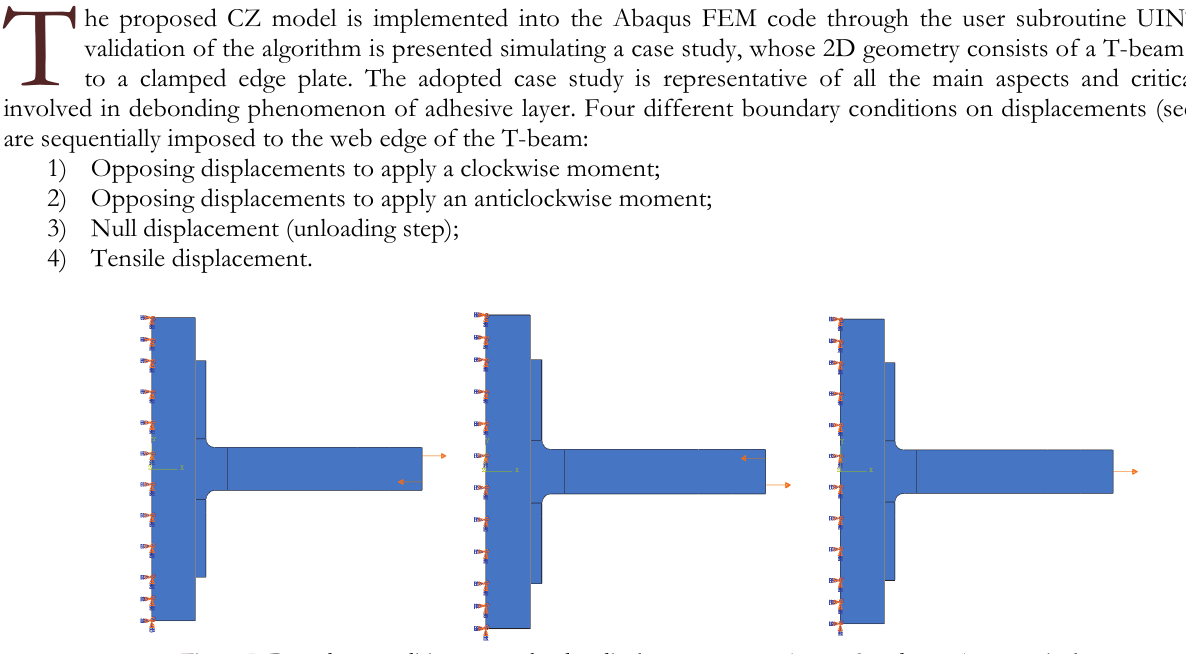
Figure 7: Boundary conditions on web edge displacements: step 1, step 2 and step 4, respectively.